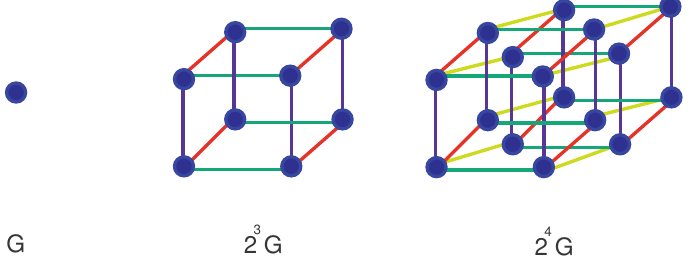
Figure 1. η ζ Γ for η = 2 and ζ = 0,3,4 when Γ is a single vertex graph.